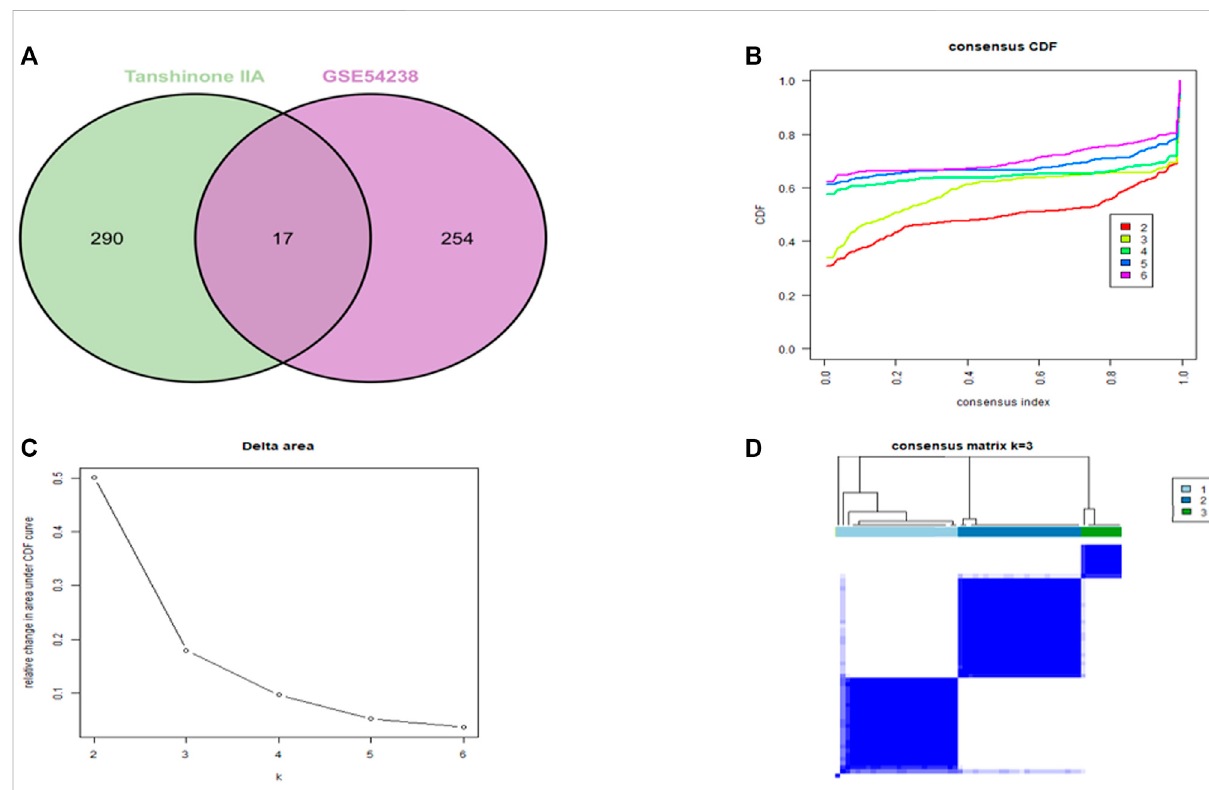
FIGURE 1 Selection of target genes. (A) Venn diagram for screening drug target genes. (B) CDF plot showing consensus distribution of target genes for each cluster (K). (C) Delta area plot, re fl ecting the relative change in the area under the CDF curve. (D) Consensus matrix heatmap depicting consensus values on a white to blue scale for each